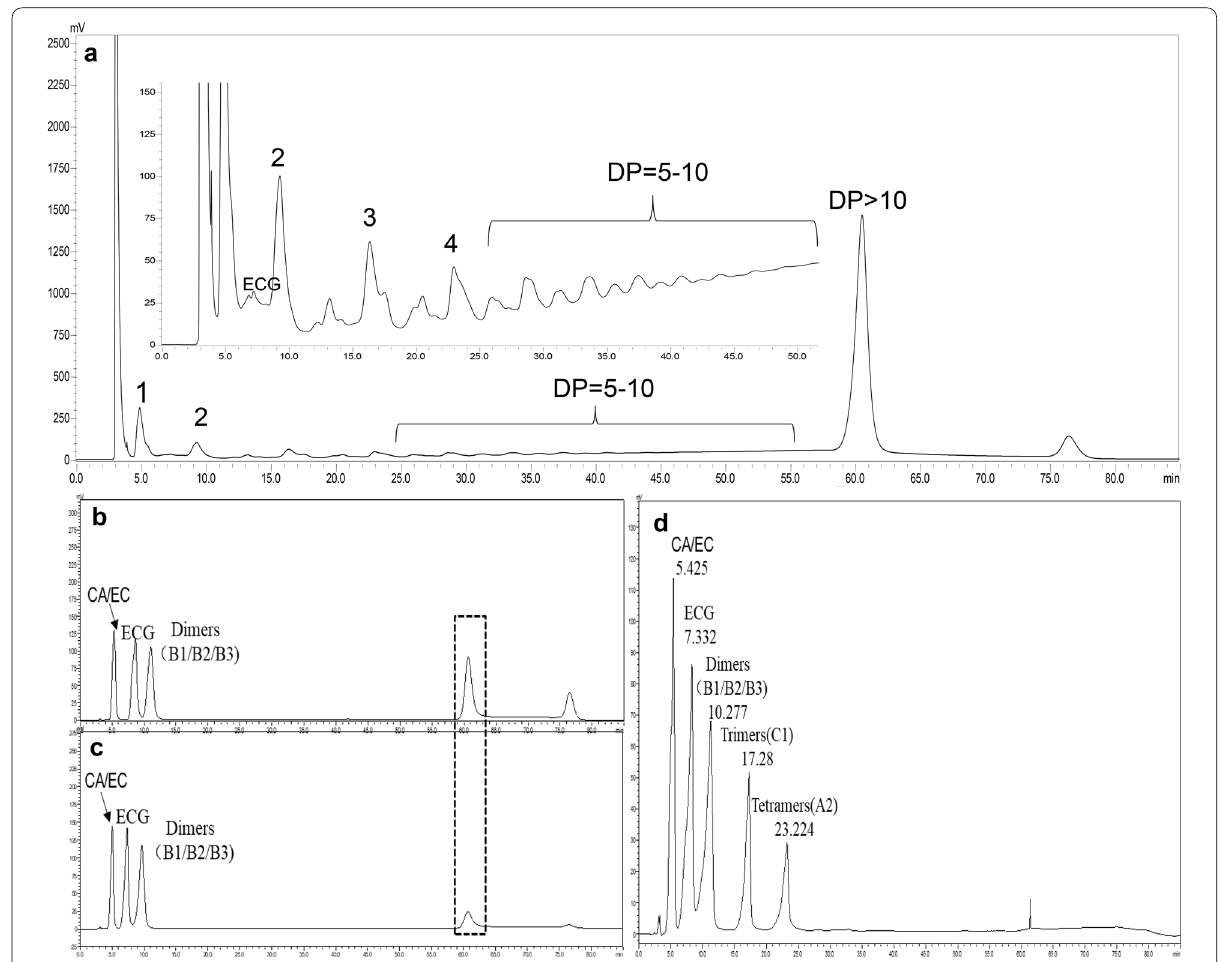
Fig. 4 NP-HPLC chromatogram of unexploded grape seeds extract and mixed standard solutions (1 4 tetramer) ( a ); mobile phases A acetonitrile/acetic acid (98:2, v/v) ( b ); mobile phases A = = EC ECG Dimers C1 A2) ( d + + + +